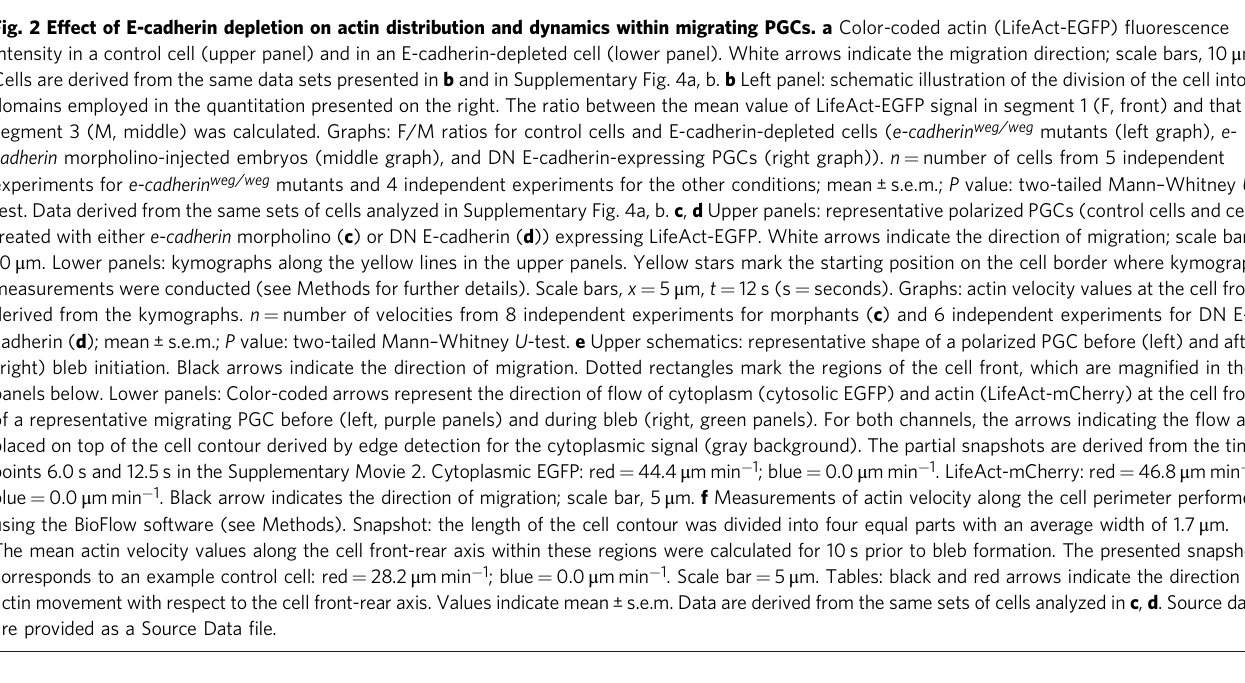
Fig. 2 Effect of E-cadherin depletion on actin distribution and dynamics within migrating PGCs. a Color-coded actin (LifeAct-EGFP) fl uorescence intensity in a control cell (upper panel) and in an E-cadherin-depleted cell (lower panel). White arrows indicate the migration direction; scale bars, 10 μ m. Cells are derived from the same data sets presented in b and in Supplementary Fig. 4a, b. b Left panel: schematic illustration of the division of the cell into 5 domains employed in the quantitation presented on the right. The ratio between the mean value of LifeAct-EGFP signal in segment 1 (F, front) and that in segment 3 (M, middle) was calculated. Graphs: F/M ratios for control cells and E-cadherin-depleted cells ( e-cadherin weg/weg mutants (left graph), e- cadherin morpholino-injected embryos (middle graph), and DN E-cadherin-expressing PGCs (right graph)). n = number of cells from 5 independent experiments for e-cadherin weg/weg mutants and 4 independent experiments for the other conditions; mean ± s.e.m.; P value: two-tailed Mann – Whitney U- test. Data derived from the same sets of cells analyzed in Supplementary Fig. 4a, b. c , d Upper panels: representative polarized PGCs (control cells and cells treated with either e-cadherin morpholino ( c ) or DN E-cadherin ( d )) expressing LifeAct-EGFP. White arrows indicate the direction of migration; scale bars, 10 μ m. Lower panels: kymographs along the yellow lines in the upper panels. Yellow stars mark the starting position on the cell border where kymograph measurements were conducted (see Methods for further details). Scale bars, x = 5 μ m, t = 12 s (s = seconds). Graphs: actin velocity values at the cell front derived from the kymographs. n = number of velocities from 8 independent experiments for morphants ( c ) and 6 independent experiments for DN E- cadherin ( d ); mean ± s.e.m.; P value: two-tailed Mann – Whitney U -test. e Upper schematics: representative shape of a polarized PGC before (left) and after (right) bleb initiation. Black arrows indicate the direction of migration. Dotted rectangles mark the regions of the cell front, which are magni fi ed in the panels below. Lower panels: Color-coded arrows represent the direction of fl ow of cytoplasm (cytosolic EGFP) and actin (LifeAct-mCherry) at the cell front of a representative migrating PGC before (left, purple panels) and during bleb (right, green panels). For both channels, the arrows indicating the fl ow are placed on top of the cell contour derived by edge detection for the cytoplasmic signal (gray background). The partial snapshots are derived from the time points 6.0s and 12.5s in the Supplementary Movie 2. Cytoplasmic EGFP: red = 44.4 μ mmin − 1 ; blue = 0.0 μ mmin − 1 . LifeAct-mCherry: red = 46.8 μ mmin − 1 ; blue = 0.0 μ mmin − 1 . Black arrow indicates the direction of migration; scale bar, 5 μ m. f Measurements of actin velocity along the cell perimeter performed using the BioFlow software (see Methods). Snapshot: the length of the cell contour was divided into four equal parts with an average width of 1.7 μ m. The mean actin velocity values along the cell front-rear axis within these regions were calculated for 10s prior to bleb formation. The presented snapshot corresponds to an example control cell: red = 28.2 μ mmin − 1 ; blue = 0.0 μ mmin − 1 . Scale bar = 5 μ m. Tables: black and red arrows indicate the direction of actin movement with respect to the cell front-rear axis. Values indicate mean±s.e.m. Data are derived from the same sets of cells analyzed in c , d . Source data are provided as a Source Data fi